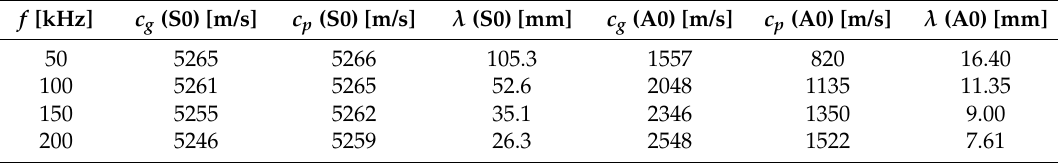
Table 1. Group and phase velocity of A0 fundamental wave propagation mode and associated wavelength of the propagating wave packets, as a function of the excitation frequency f